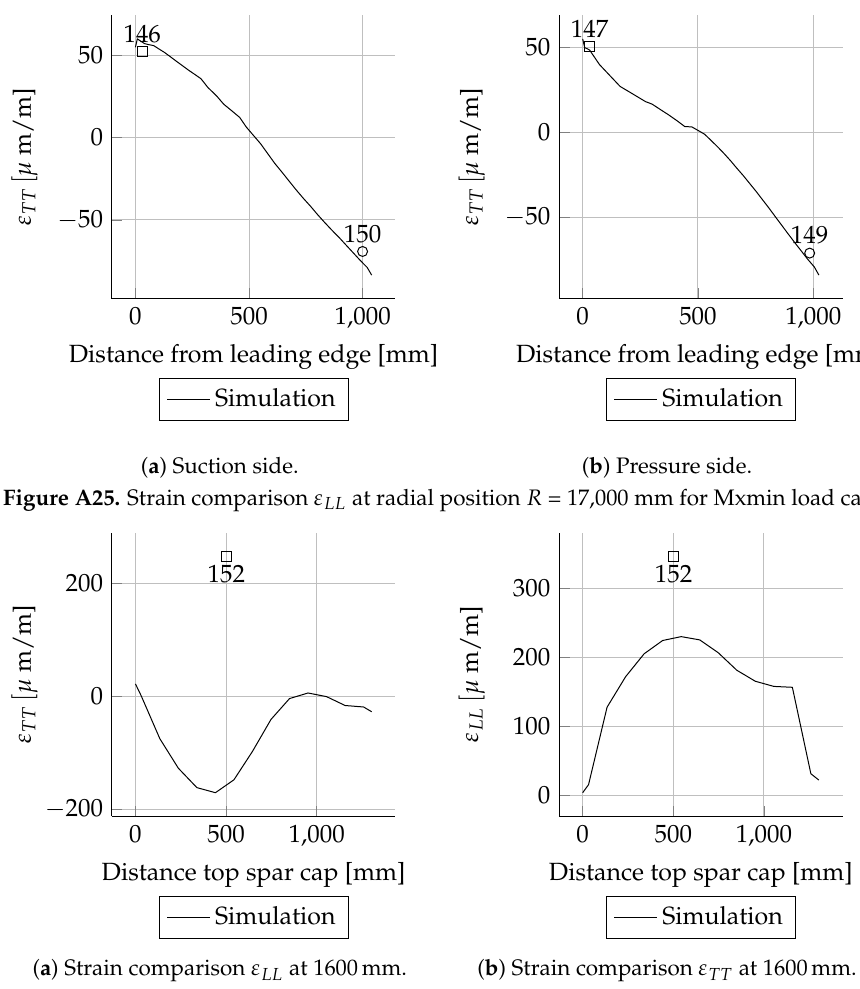
Figure A26. Cont